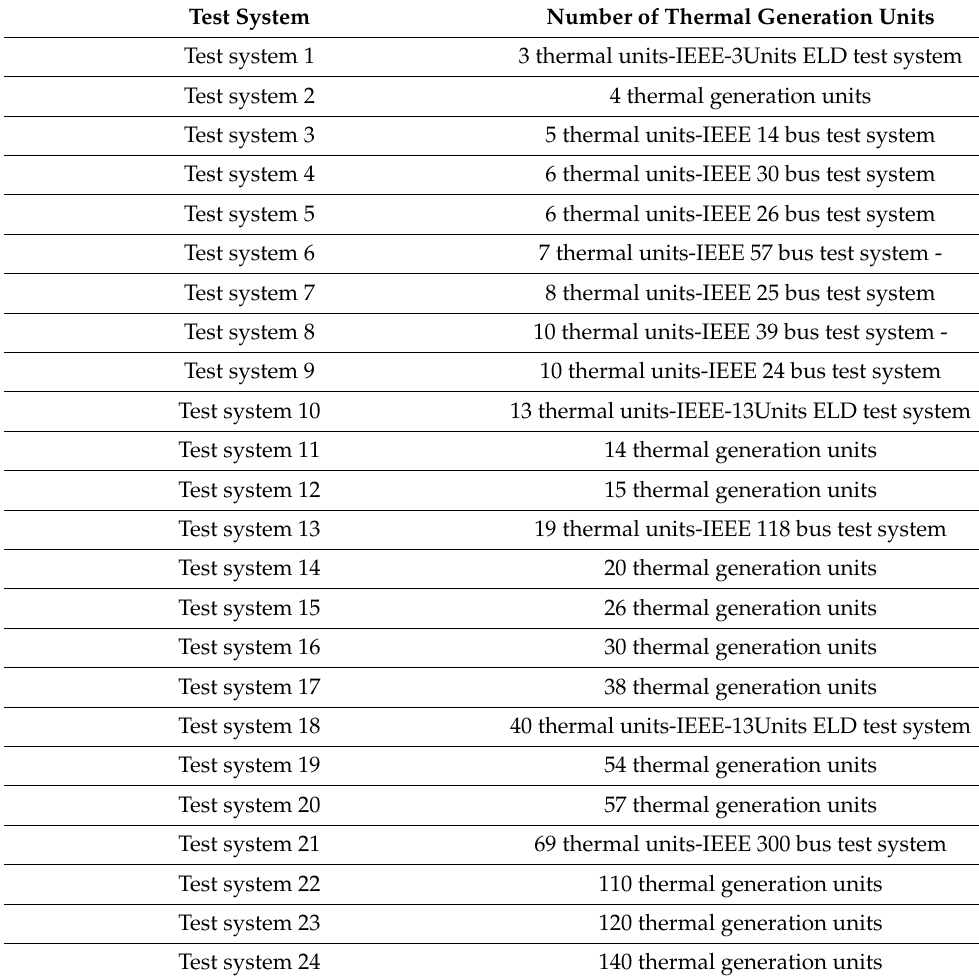
Table 1. Definition of test systems studied for the solution related to CEED